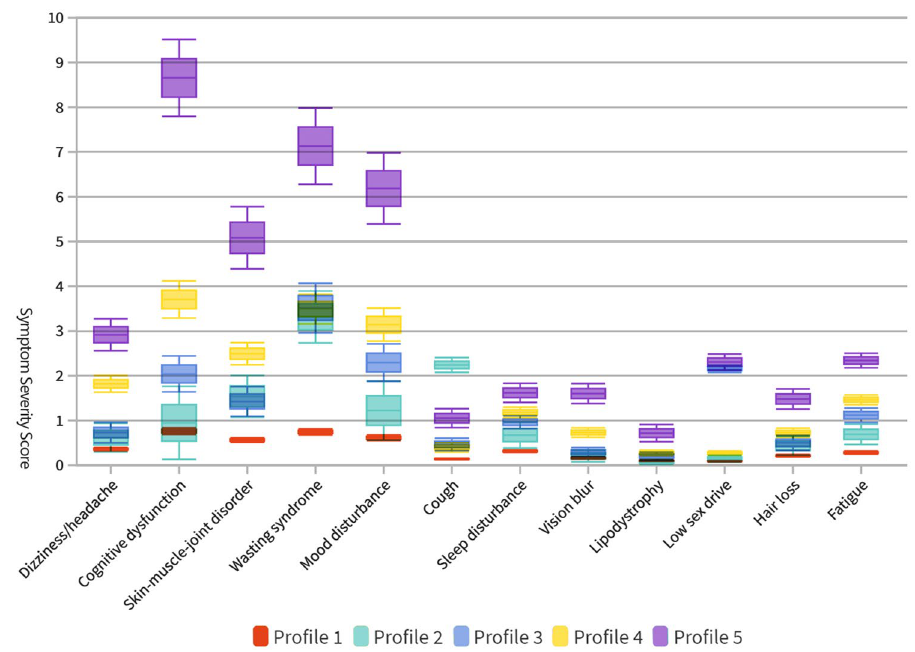
Figure 1. Symptom severity score of 5 latent profiles for 5 symptom clusters and 7 symptoms (n =